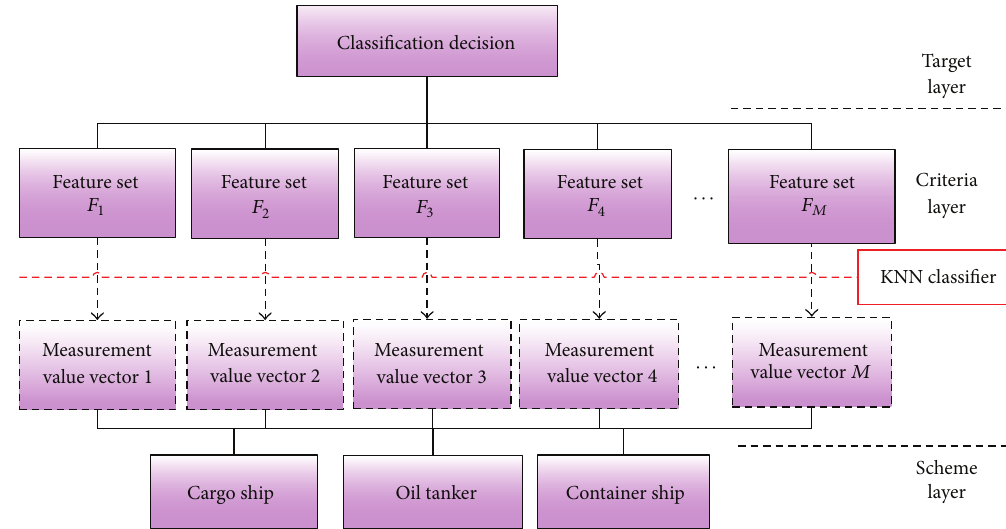
Figure 3: Hierarchy model for classification decision based on single